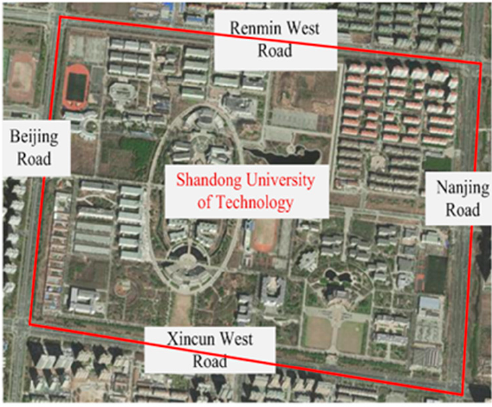
Int. J. Environ. Res. Public Health 2019 , 16 , x Figure 4. Driving route of the real vehicle experiment. Figure 4. Driving route of the real vehicle experiment.